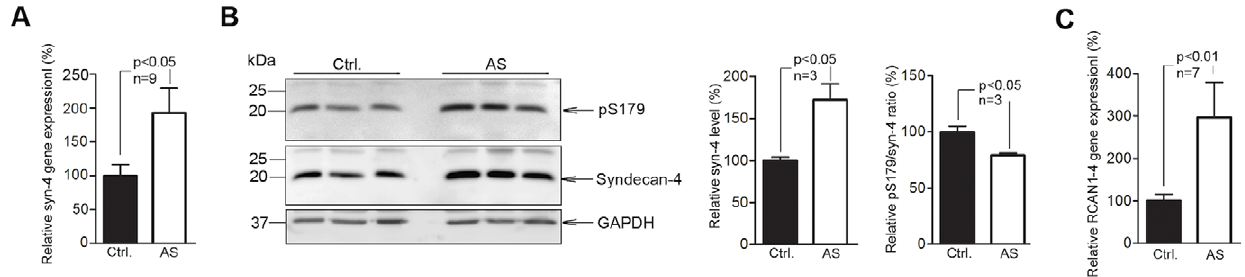
Figure 7. Increased myocardial syndecan-4 levels and reduced serine 179 phosphorylation (pS179) in patients with aortic stenosis. (A) Real-time PCR analysis of syndecan-4 (n=9), (B) immunoblots of pS179-syndecan-4 (top panel) and syndecan-4 (bottom panel) levels with relative syndecan-4 and pS179-syndecan-4/syndecan-4 ratios (n=3) and real-time PCR analysis of regulator of calcineurin 1–4 (RCAN1-4) (n=7) (C) in myocardial biopsies from patients with severe aortic stenosis (AS) versus control patients. GAPDH was used for loading control. Values are mean 6 s.e.m.